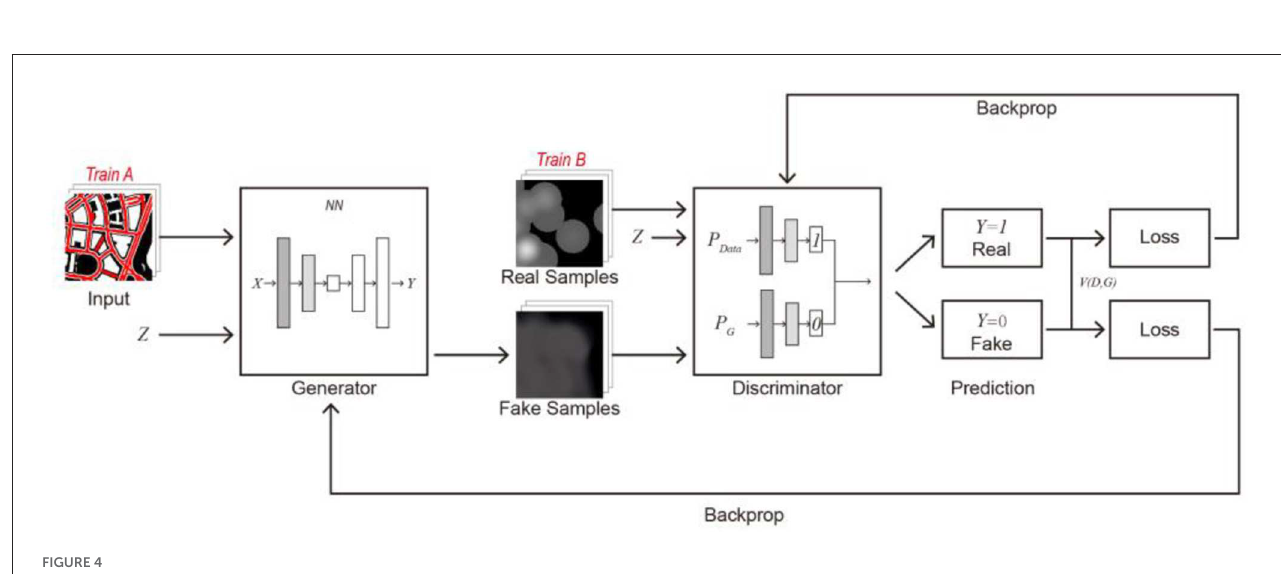
higher similarity for images with similar brightness and darkness. Herein, the COVID-19 trajectory prediction results are presented as grayscale heat maps. The comparison of histograms, which are highly sensitive to the grayscale values of images, well reflects the accuracy of the model